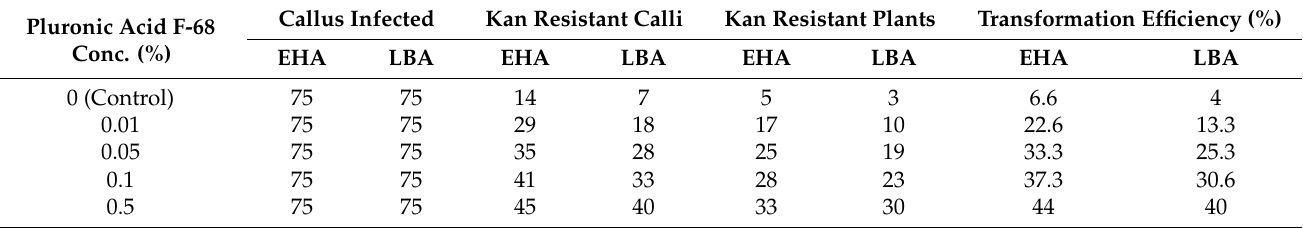
Table A7. Effect of Pluronic acid F-68 on transformation efficiency of callus derived from seeds of P. scrobiculatum L. Pluronic Acid F-68 Conc. (%)